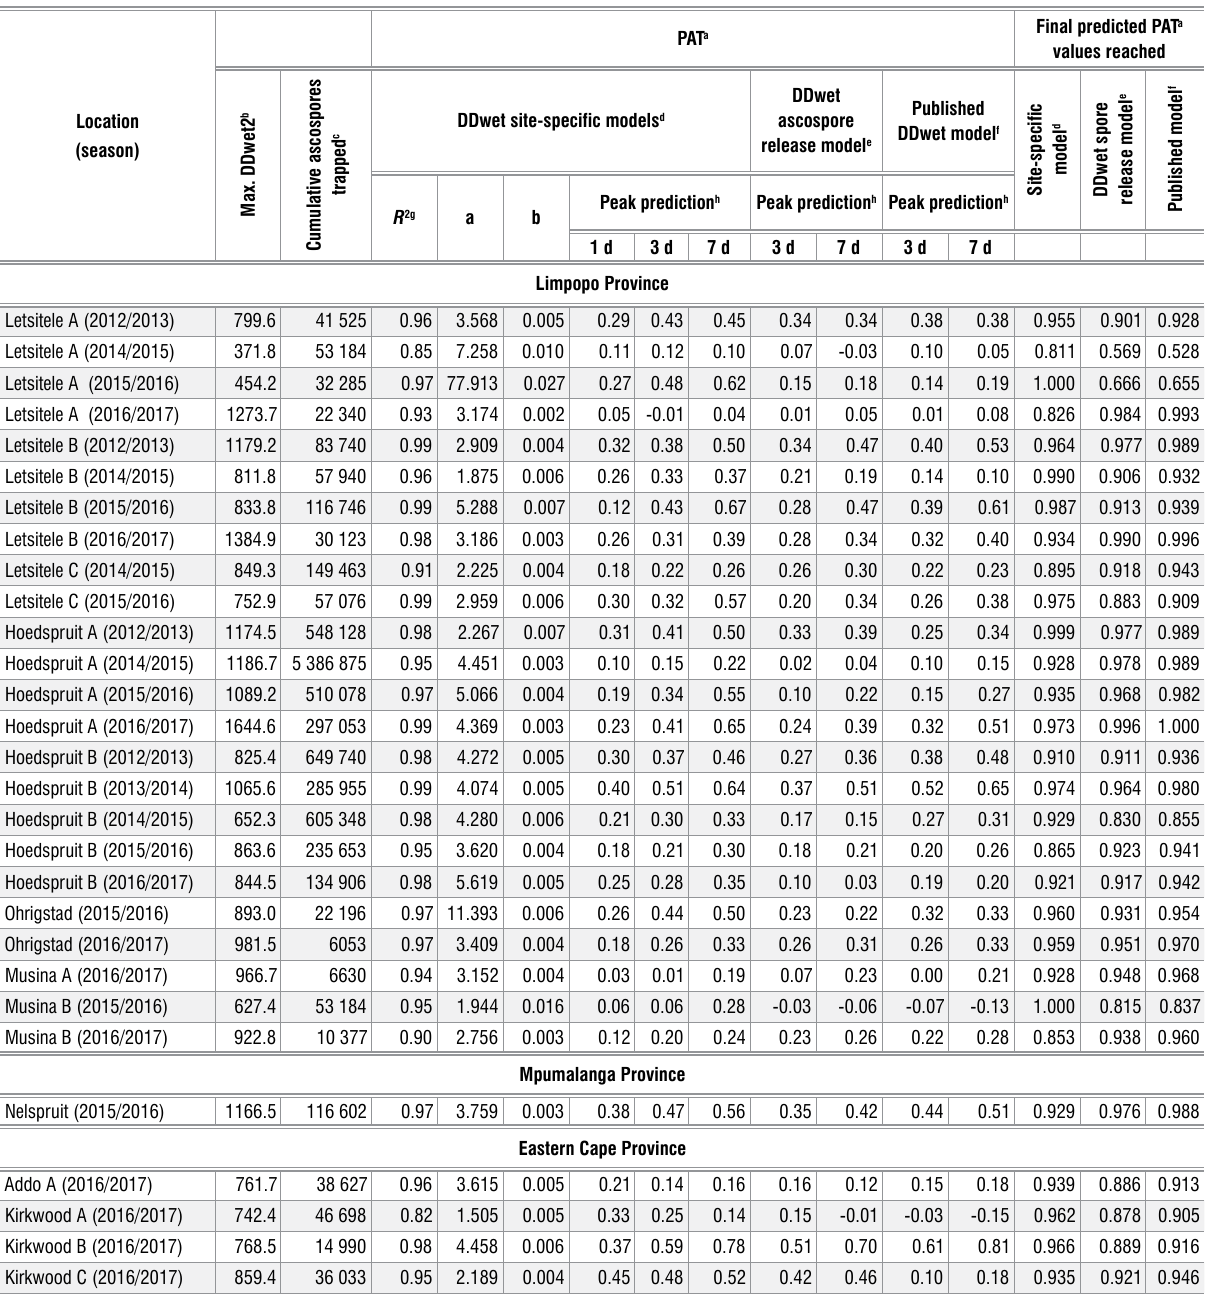
Maximum cumulative DDwet2 values, cumulative ascospore trap numbers (spores/m 3 ) and final proportion of ascospores trapped (PAT) values predicted by the site-specific and generic DDwet ascospore release models, as well as a published DDwet model 23 , for different locations and seasons. Correlation coefficients obtained between 1-day, sum of rolling 3-day (each particular day plus previous 2 days accumulation in PAT) and 7-day (each particular day plus previous 6 days accumulation in PAT) actual PAT and that predicted by site-specific and generic DDwet ascospore release models, as well as a published DDwet model 23 are also